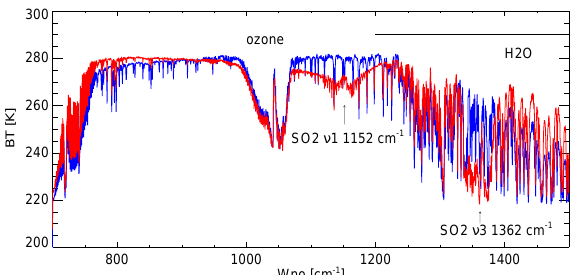
Fig. 2. Blue line shows an IASI spectrum obtained from outside of the Kasatochi volcanic plume on 10 August over ocean and the red line shows an IASI spectrum obtained inside the plume.